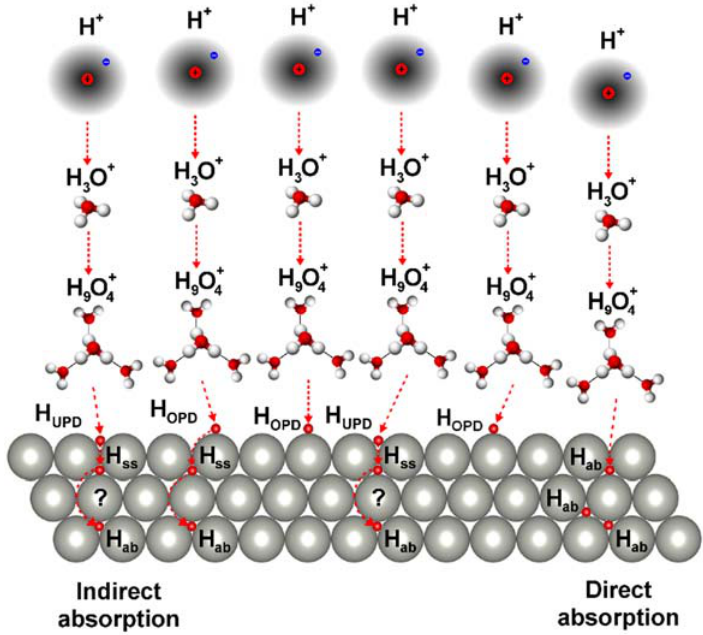
Figure 6. A schematic model of hydrogen absorption mechanism into Pd 80 Rh 20 foil of the fcc structure in aqueous acidic solution in which the hydrogen atoms are depicted in red.